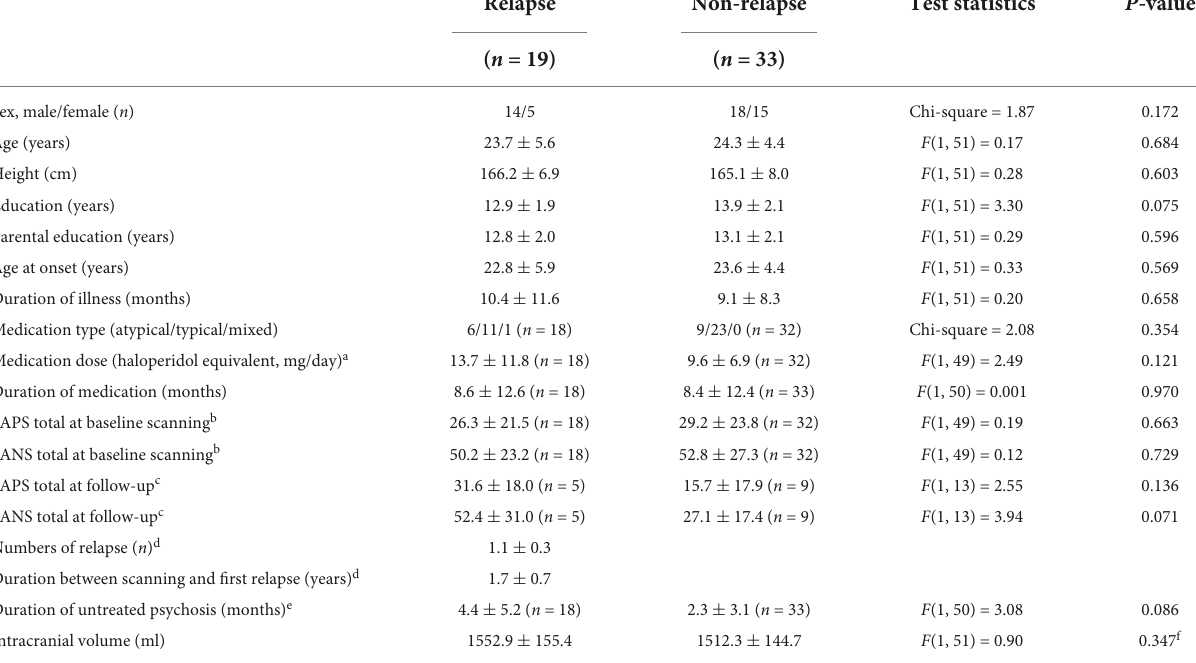
TABLE 1 Demographic characteristics of study participants.